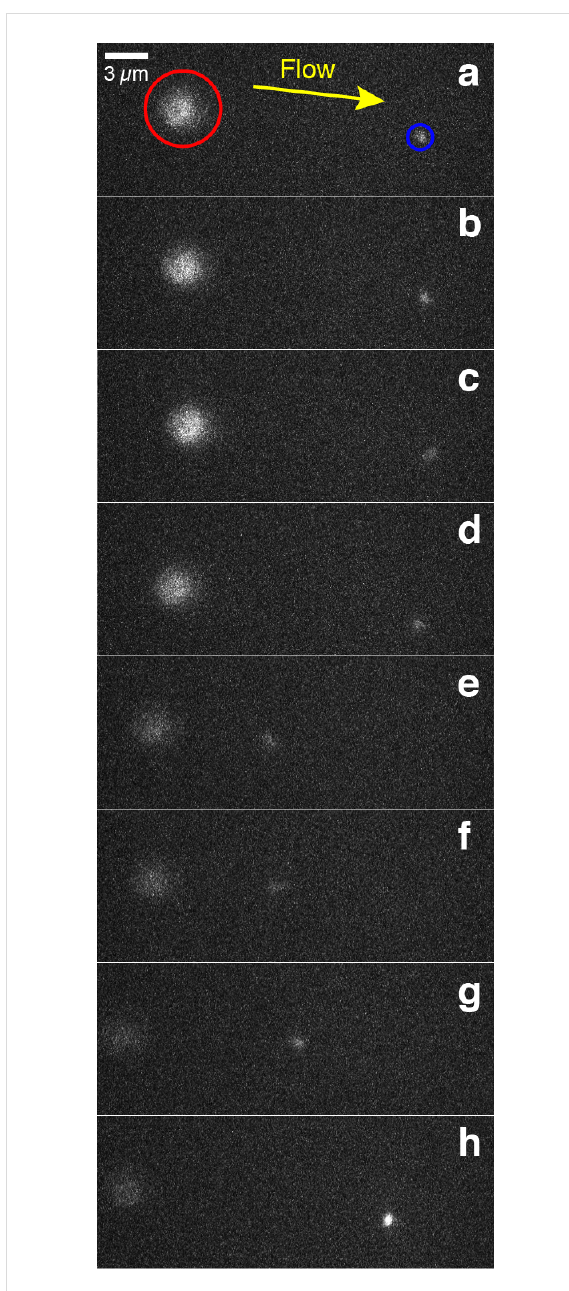
Figure 8: Fluorescence measurements of Qdot–streptavidin conjug- ates that were attached to freely accessible DIG - λ -dsDNA-Bio strands. a) The blue circle highlights the fluorescent emission of a quantum dot at 525 nm, and the red circle shows the auto-fluorescent bead on the pipette, the yellow arrow represents the direction of the flow. b–h) are the consecutive images obtained via EMCCD video recording. These images show one cycle of the relative position change of the tethered quantum dot, whilst bound to the biotinylated end of a single DIG- λ -DNA-Bio strand within the microfluidic chamber. It can be seen that the freely accessible Qdot changes its position ac- cording to the flow. a–c depict a constant fast fluid velocity. d–e show a sudden decrease and f–h a gradual increase in the flow rate within the microfluidic cell. Variations in the fluid flow speed change the hydro- dynamic drag experienced by the long dsDNA molecule, altering its